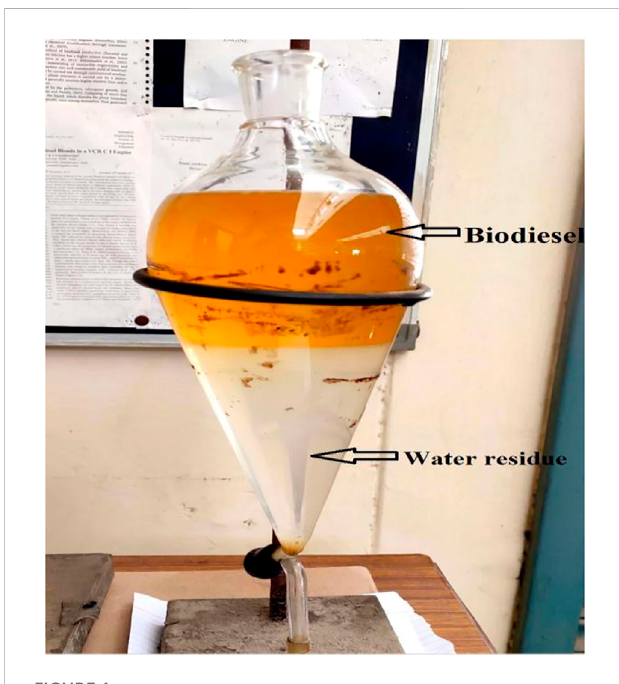
FIGURE 1 Water washing in separating